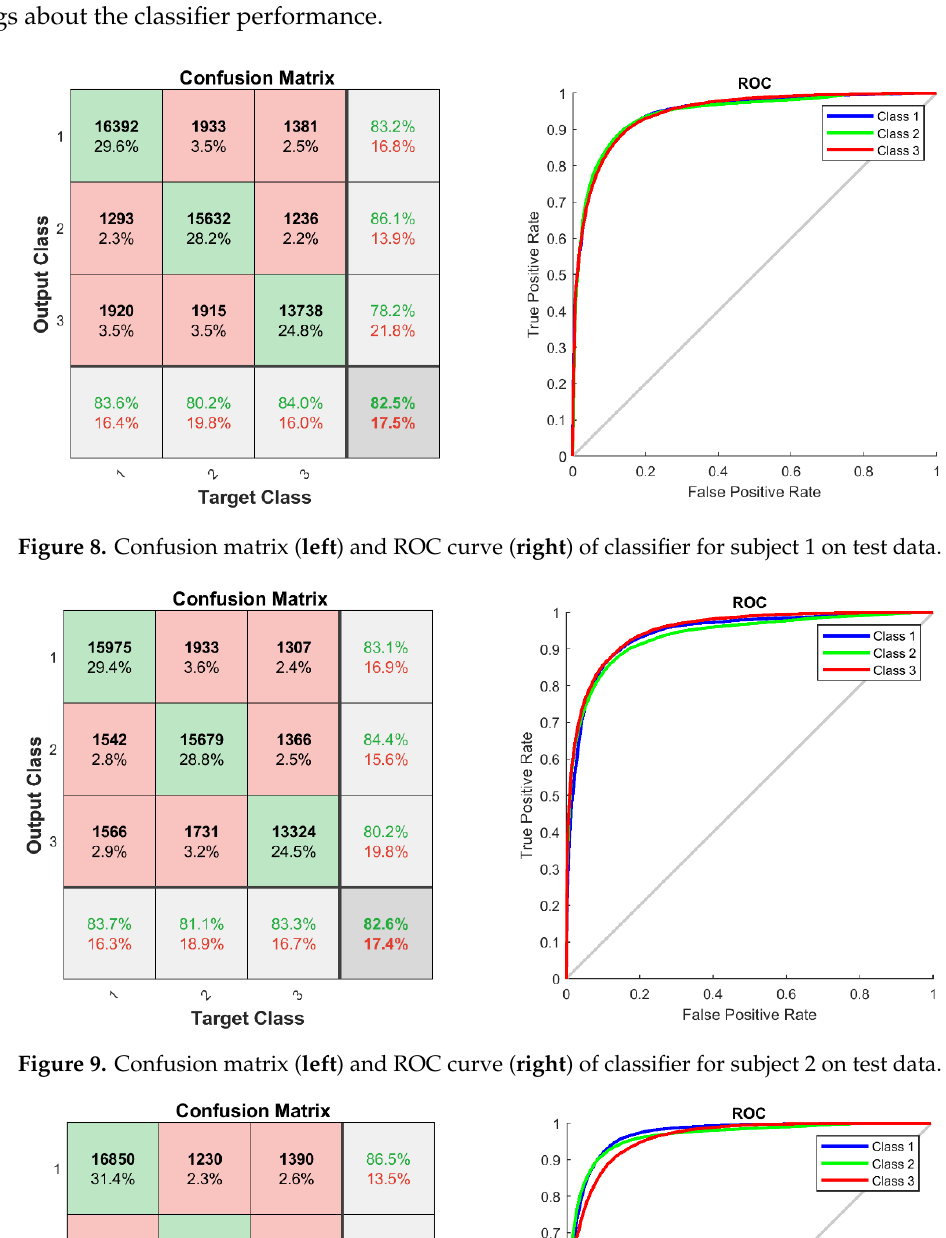
Figure 9. Confusion matrix ( left ) and ROC curve ( right ) of classifier for subject 2 on test data.